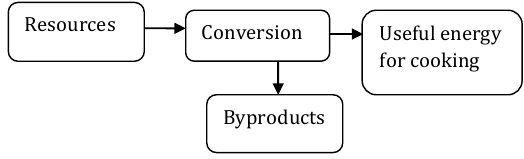
Figure 1. Schematic diagram of household energy resources flow.